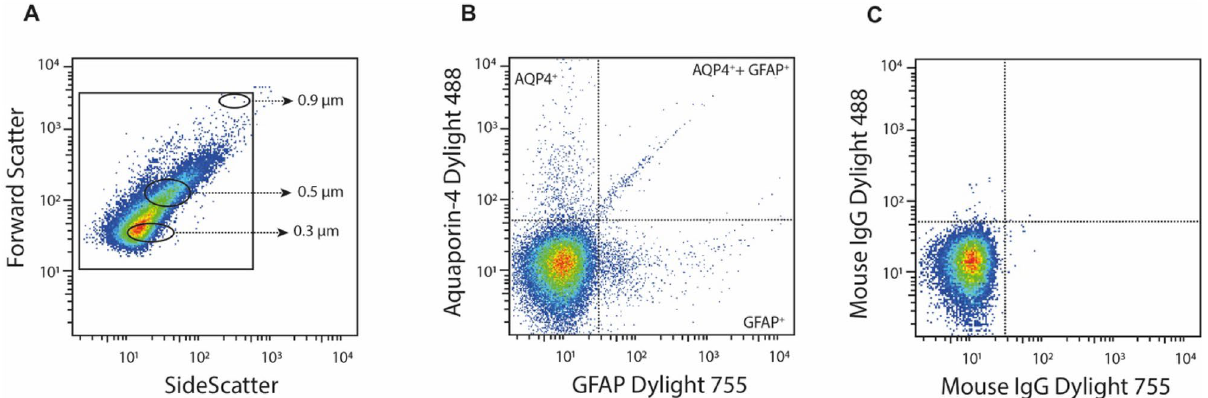
Figure 1. Flow cytometric analysis of astrocyte-specific extracellular vesicles in patients with stress-induced exhaustion disorder (SED). ( A ) Representative dot-plot of extracellular vesicle gating (based on size and complexity) together with gates demonstrating beads with a diameter of 0.3, 0.5, and 0.9 µm. ( B ) Representative dot-plot demonstrating aquaporin 4 (AQP4) and glial fibrillary acidic protein (GFAP) expression as well